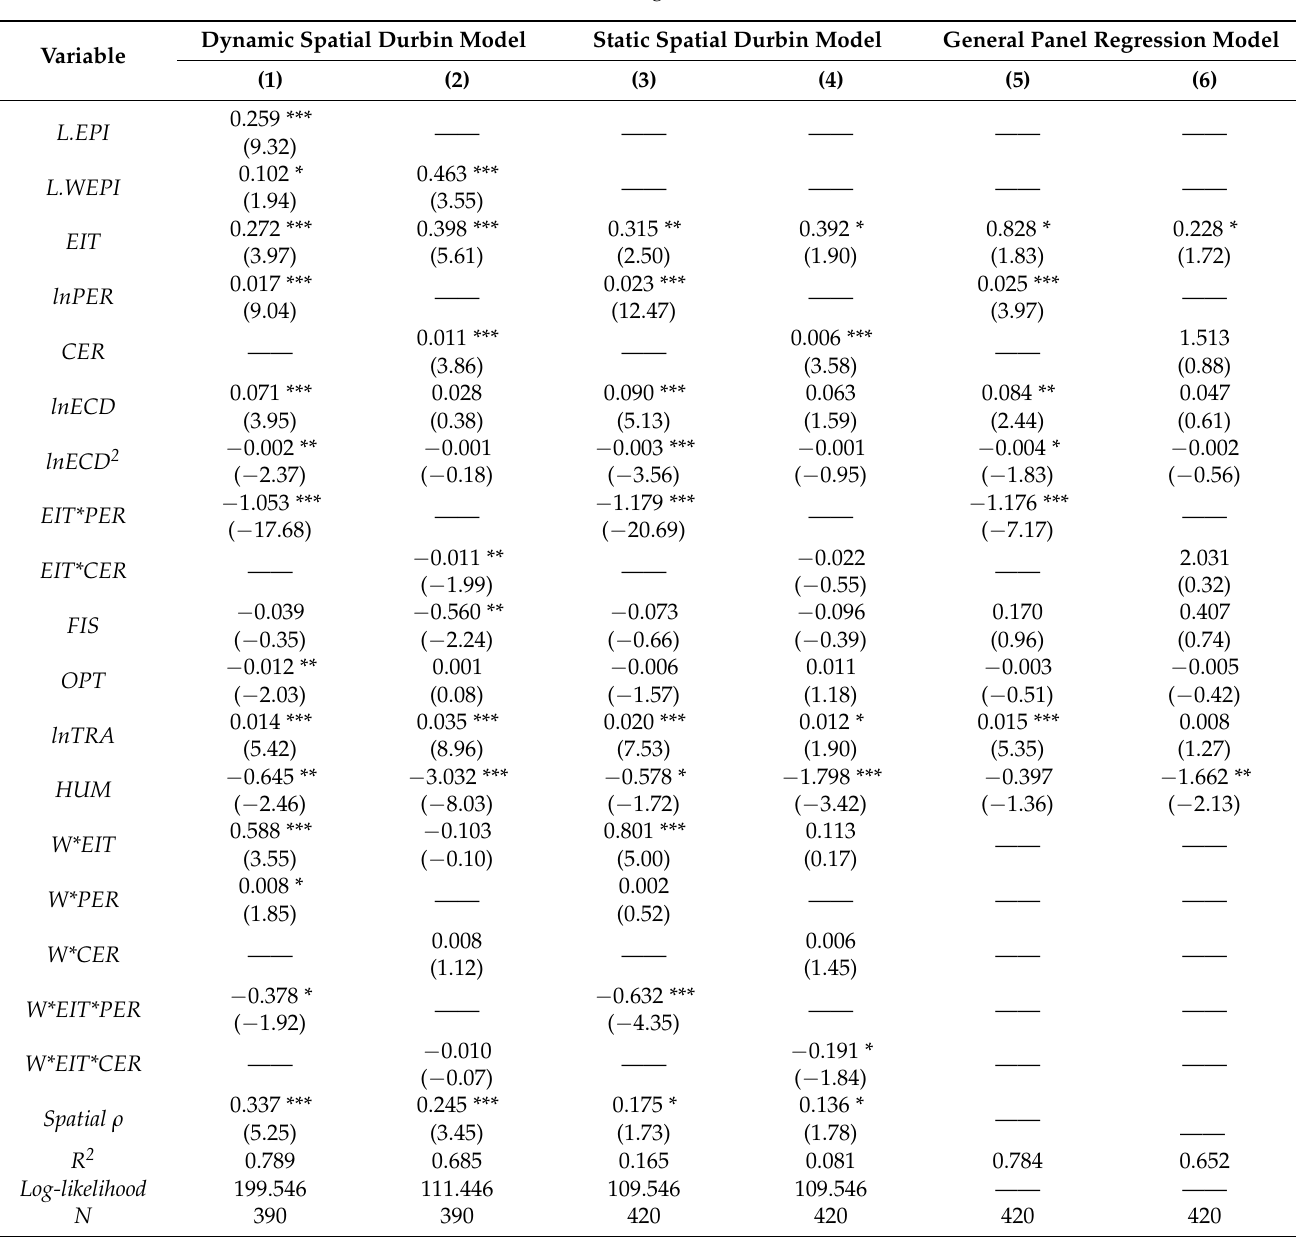
Table 4. Model regression